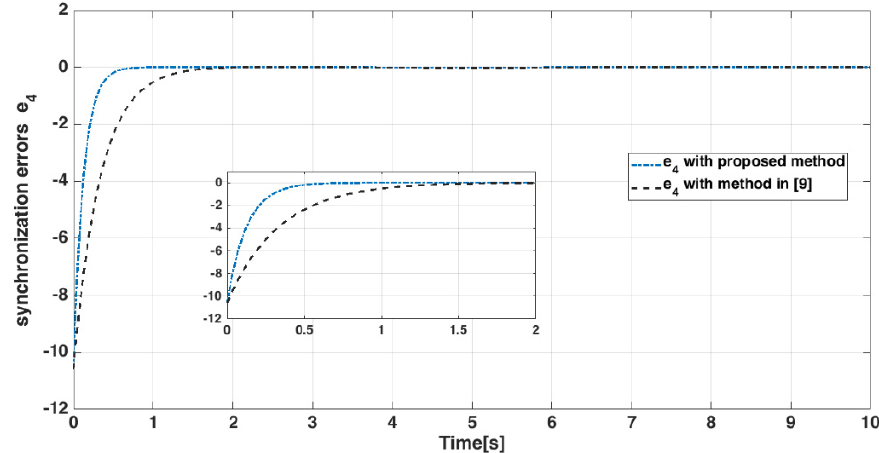
Figure 16. State errors 𝒆 𝟑 of master-slave systems